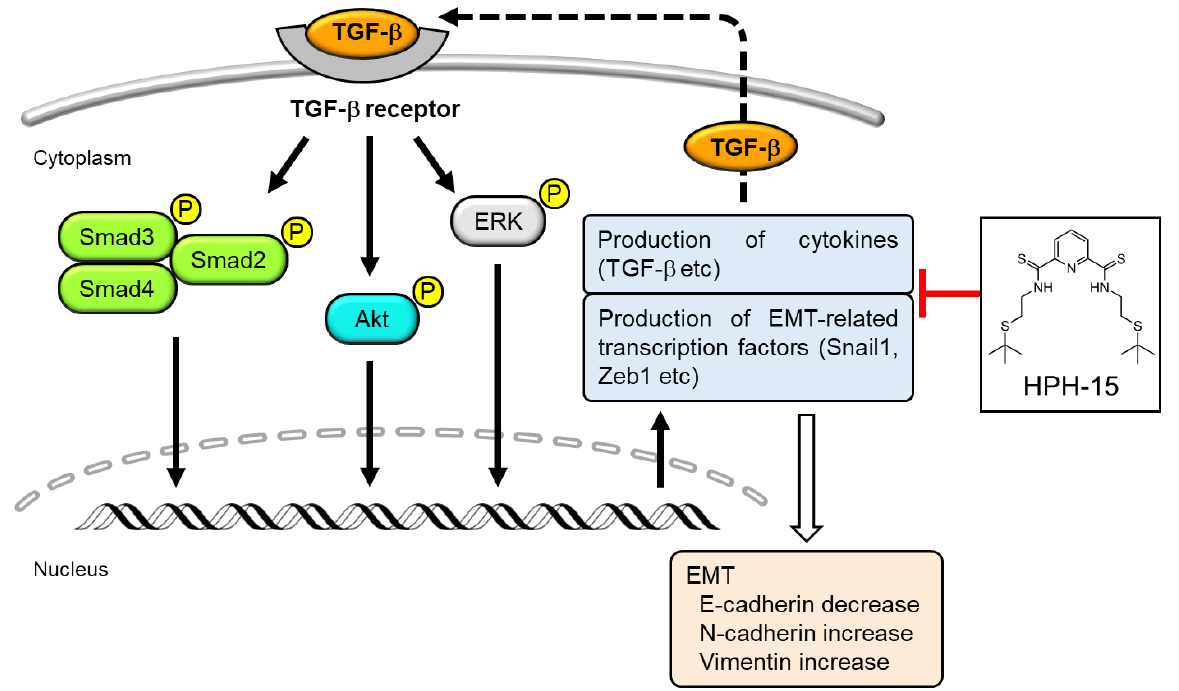
Figure 7. Schematic representation of action mechanism of HPH-15 proposed in this study.